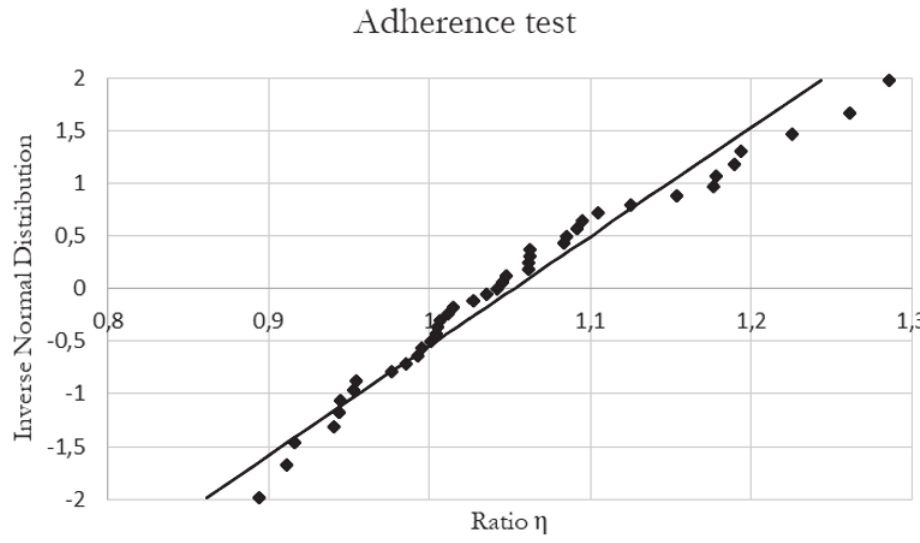
Adherence to Gauss distribution theoretical